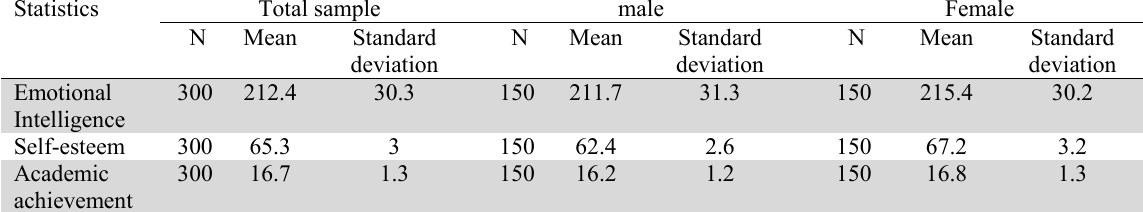
As Table 2 indicates correlation between emotional intelligence and academic achievement is r= 0.035 and between self–esteem and academic achievement correlation is r = 0.079. The data indicates that